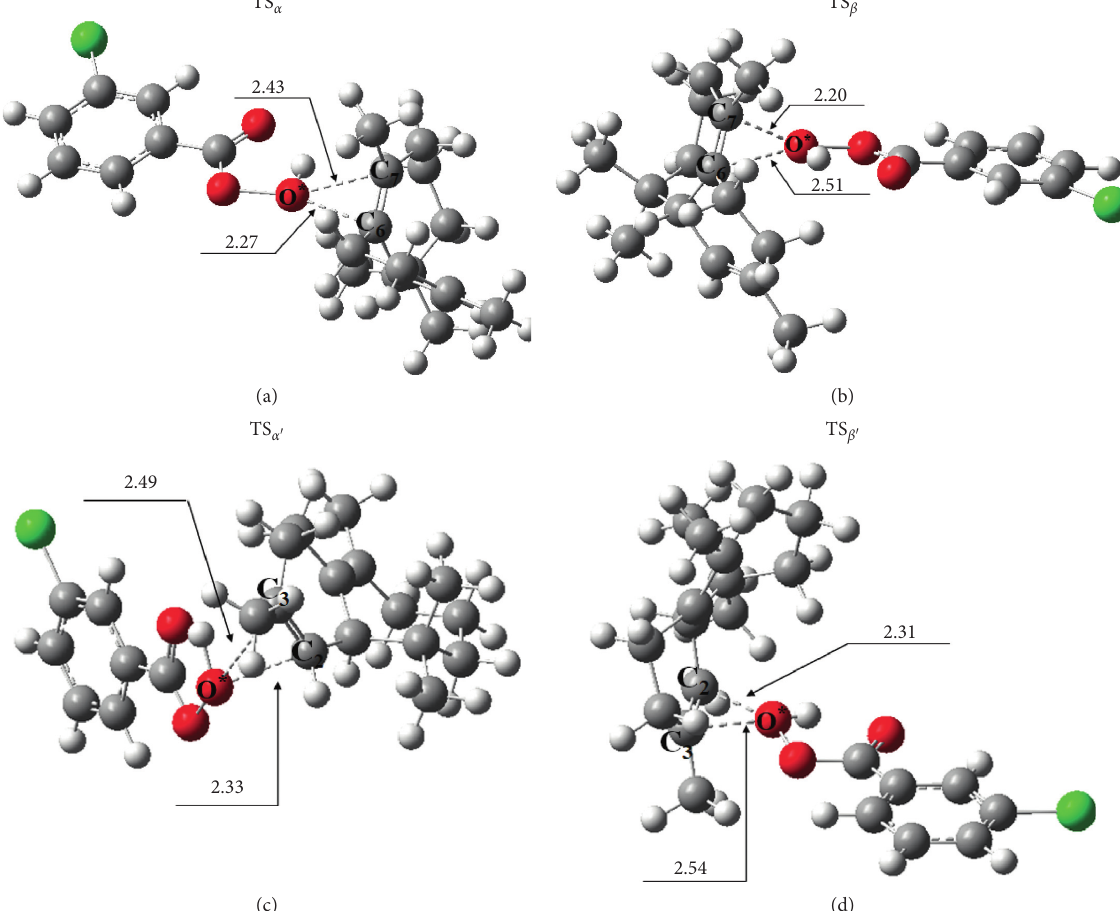
Figure 5: Optimized geometries of the transition states TS α , TS β , TS α ’ , and TS β ’of the β -himachalene and m-CBPA (the distances are given in Table 4: Electronic chemical potential ( μ ), chemical hardness ( η ), electrophilicity ( ω ), and nucleophilicity ( N ) of the major product (P α ) and CBr 2 calculated at B3LYP/6-311 +G (d, p) level (eV). P α CBr 2